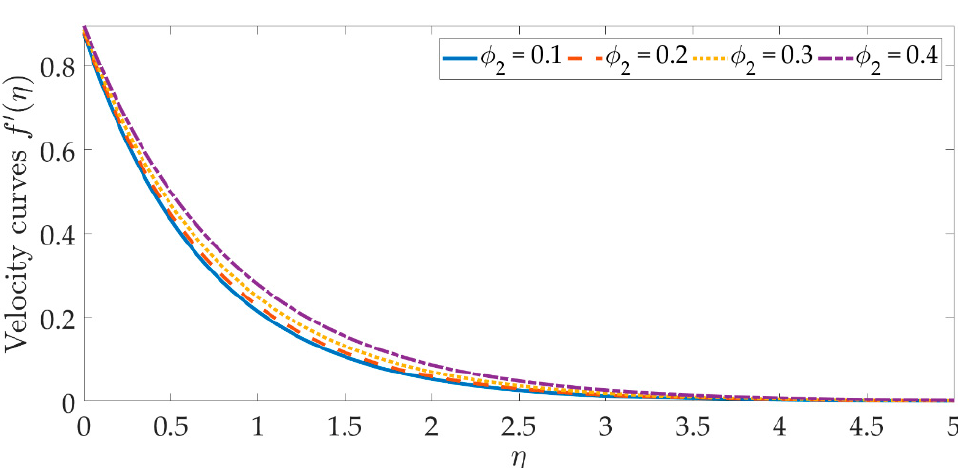
Figure 3. Velocity curves against the multiple values of 1 .